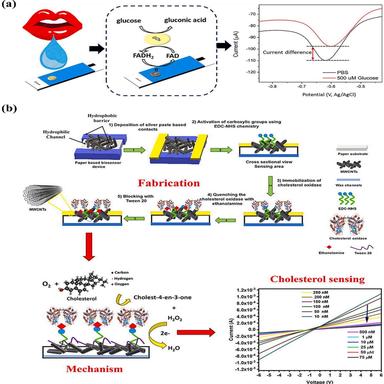
(a) Electrode modification for (a) electrochemical salivary glucose detection. Reproduced with permission and (b) carbon nanotube composite-based electrode modification for electrochemical cholesterol detection. Reproduced with permission.